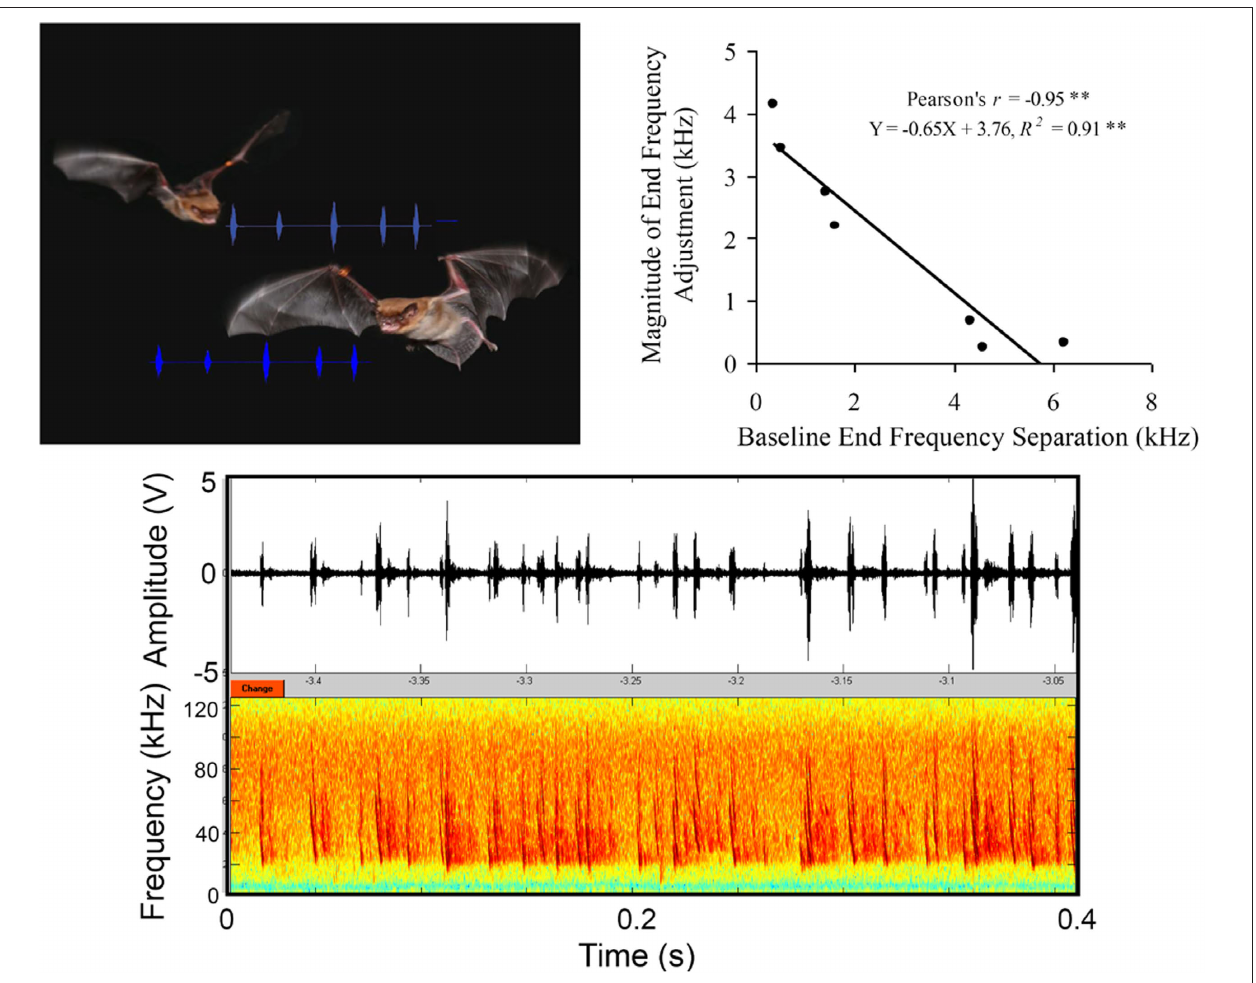
frequency the FM sweep of their calls than those with different baseline calls. Bottom panel shows raw sonar signal recording segment from two bats flying together in close proximity. Call assignment to the vocalizing bat could be made by combining three microphone recordings and 3D video position data. Adapted from Chiu et al.